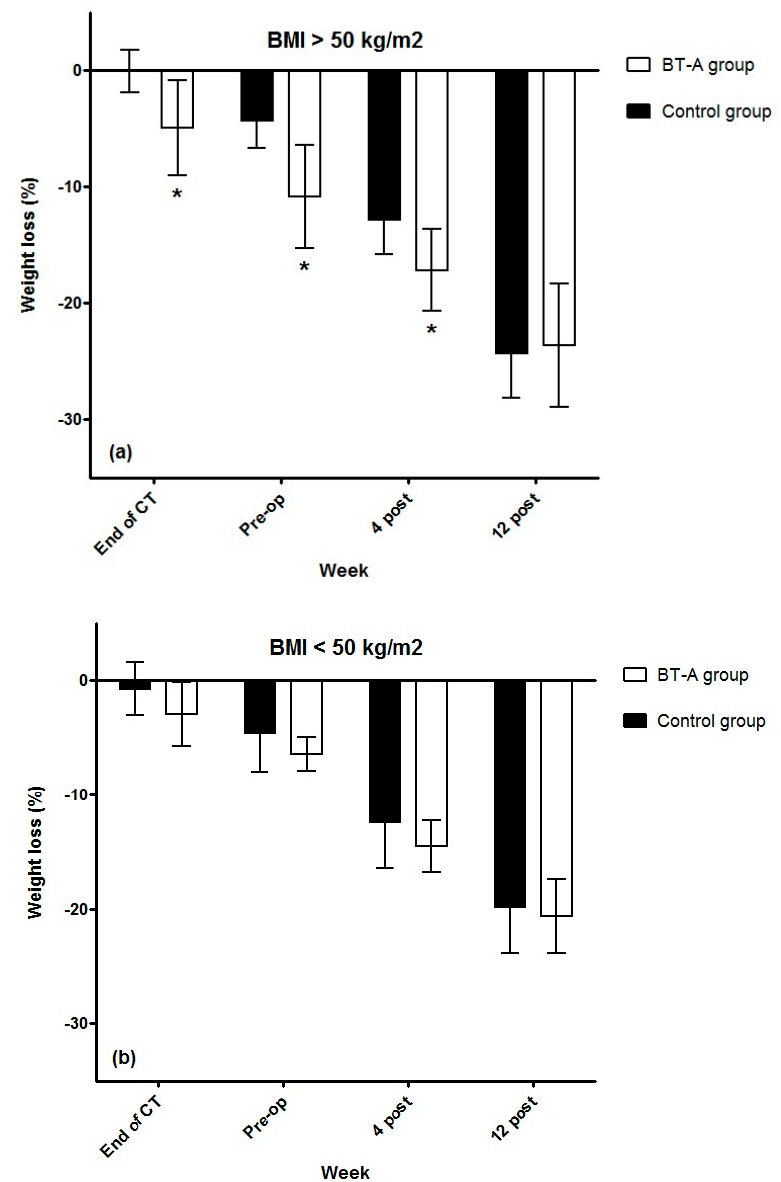
Figure 3. ( a ) Changes in body weight percentage at perioperative period in patients with BMI over 50 kg/m 2 ; ( b ) Changes in body weight percentage at perioperative period in patients with BMI below 50 kg/m 2 . * Statistically different means versus control group. Abbreviations: BT-A, botulinum toxin A; CT, clinical trial; pre-op, preoperative; post, postoperative.